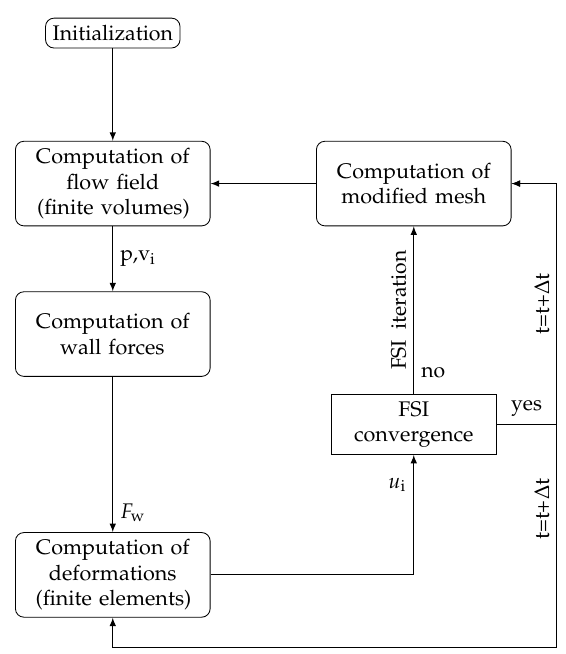
Figure 2. Coupling procedure. FSI: fluid–structure